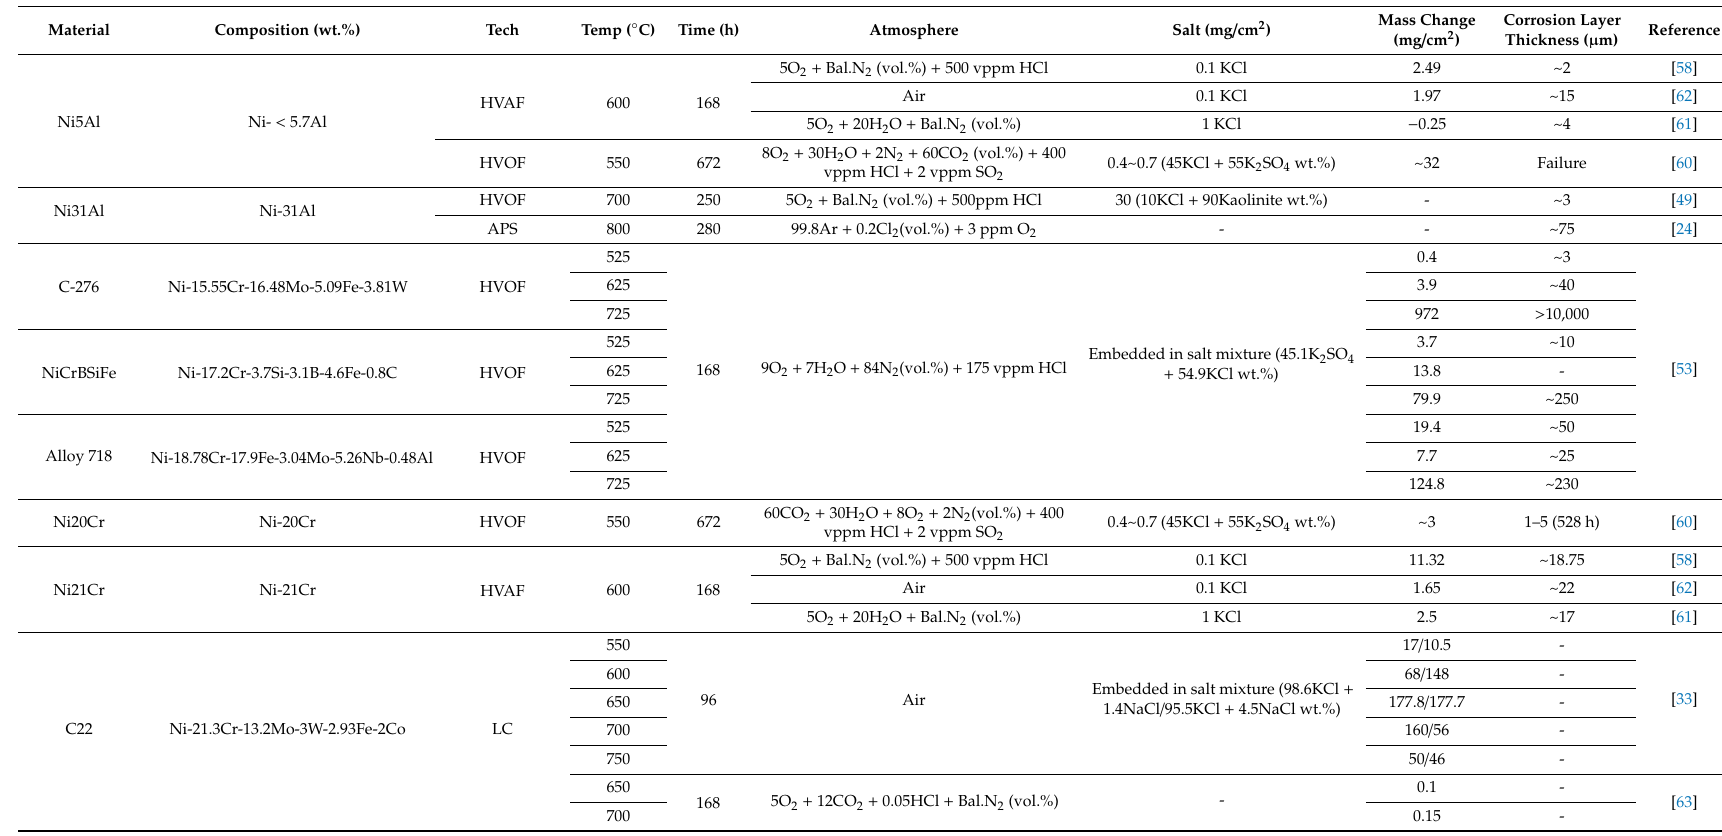
Table 4. List of various materials studied by di ff erent authors in high-temperature biomass corrosion-related environments.